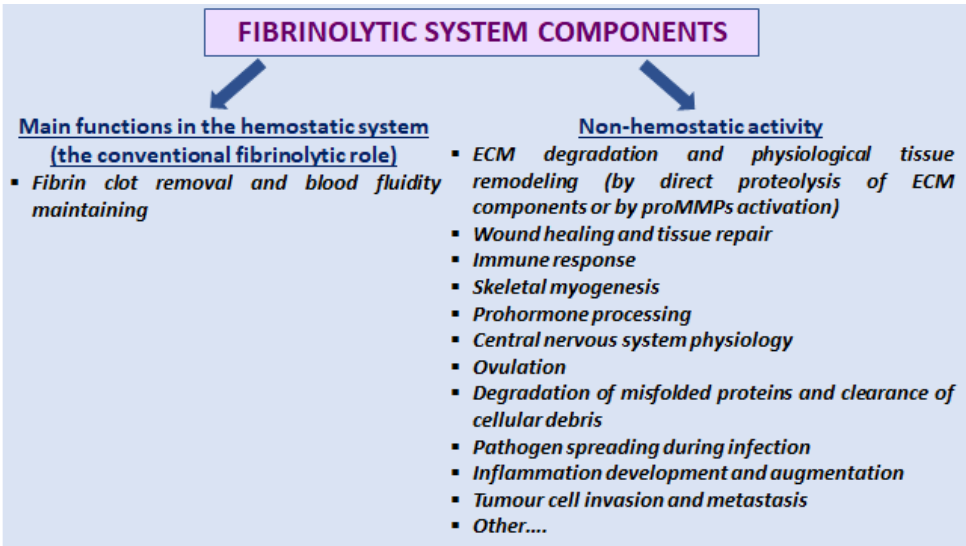
Figure 1. Brief representation of hemostatic and non-hemostatic activity of the fibrinolytic system. ECM - extracellular matrix; proMMPs - matrix metalloproteinase zymogenes.